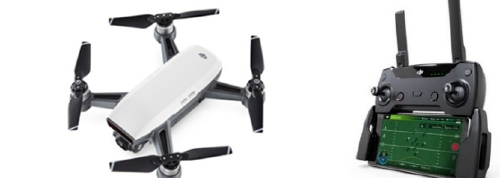
Figure 3. DJI Spark (left) and its remote controller (right).